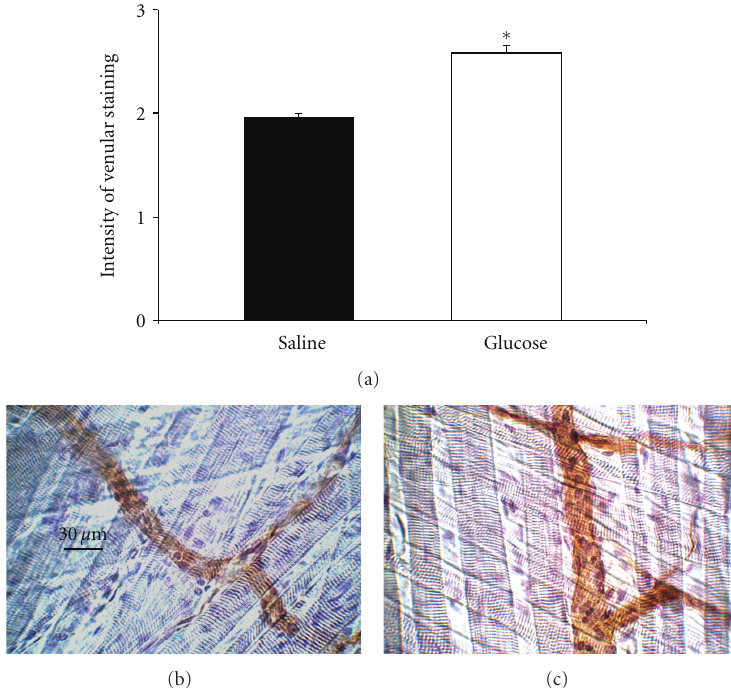
Figure 5: Glucose-induced expression of ICAM1 in surgically prepared cremaster muscle venules. Immunostaining was conducted to assess endothelial expression of ICAM1 in postcapillary venules of cremaster muscles obtained 15 minutes after exteriorization and injection of 0.5 g/kg glucose or the equivalent volume of normal saline. Application of primary antibody was performed i.v. before harvesting the cremaster muscle in order to stain ICAM1 on the endothelial surface. Biotinylated secondary antibody, peroxidase-conjugated streptavidin, and diaminobenzidine (DAB) were used to detect endothelial expression of ICAM1 as brown signal. Counter-staining was performed by Mayer’s hemalaun. Intensity of venular anti-ICAM1 immunostaining during trauma-induced inflammation was analyzed semiquantitatively and presented as mean ± SEM (a; 0 = no, 1 = weak, 2 = medium, 3 = strong signal; at least 3 mice/group). In addition, representative images of saline- and glucose-treated mice are depicted in (b) and (c), respectively. Reference bar is shown in (b) and represents 30 μ m. Significant di ff erences ( P < 0 . 05) are indicated by the